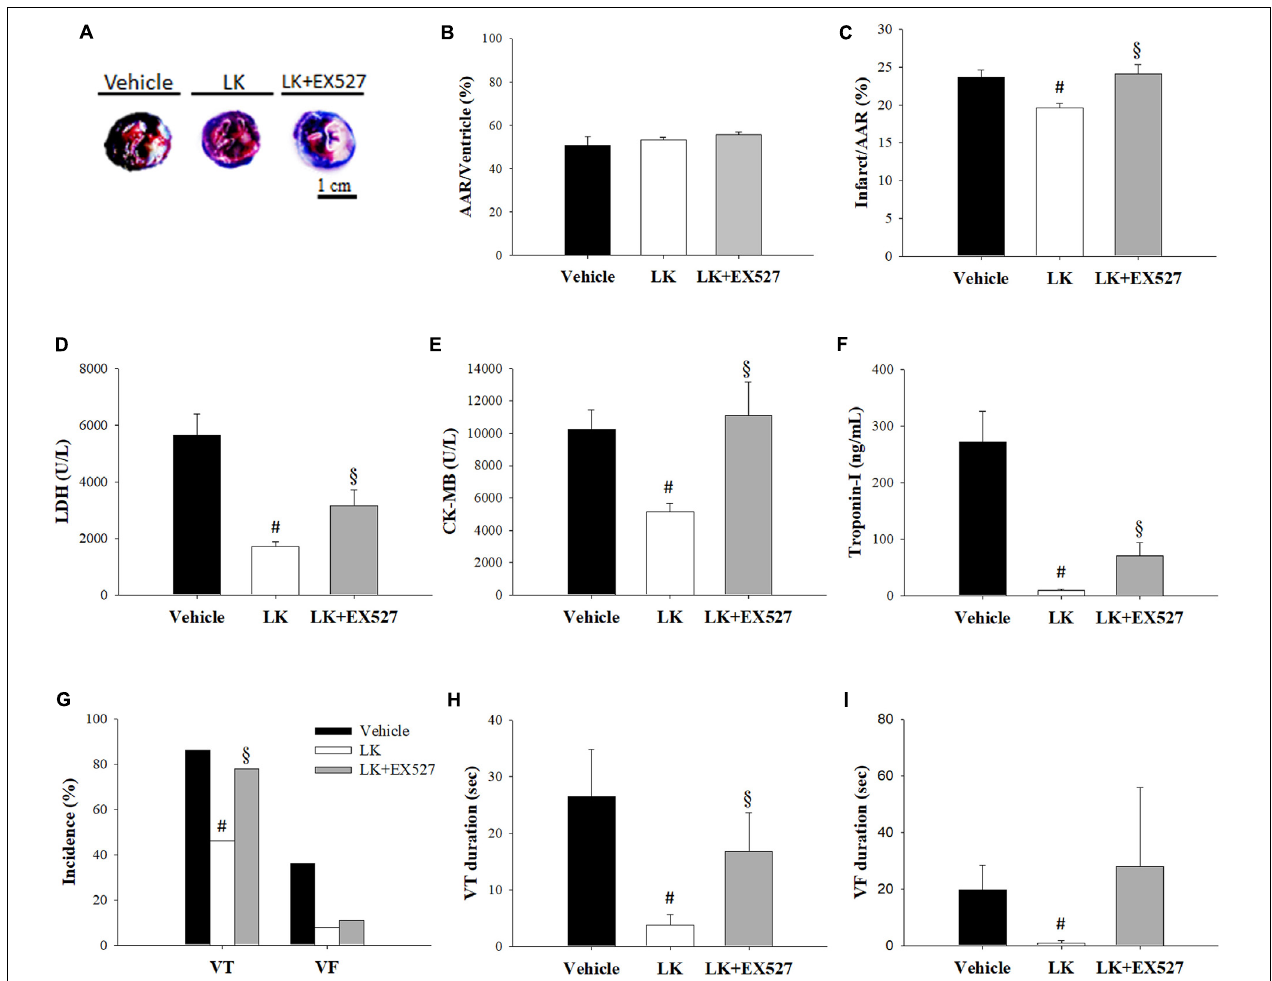
FIGURE 8 | Post-ischemic lumbrokinase treatment attenuated myocardial damage via the Sirt1 signaling pathway. Myocardial infarct size was evaluated by Evans blue/TTC staining. (A) Representative images of heart horizontal sections. The blue area depicts non-ischemic tissue, red plus white depicts at-risk tissue, white depicts infarcted tissue. (B) The area at risk (AAR) was measured relative to the ventricle and (C) the infarct was measured relative to the AAR. The activities of (D) LDH, (E) CK-MB, and the levels of (F) troponin-I were assessed by an automated clinical analyzer. (G) The incidence of VT and VF and the duration of (H) VT and (I) VF were monitored during 30 min of ischemia followed by 3 h of reperfusion. Each value is represented as the mean ± SEM ( n = 4–13). # p < 0.05 compared with the vehicle group; § p < 0.05 compared with the LK